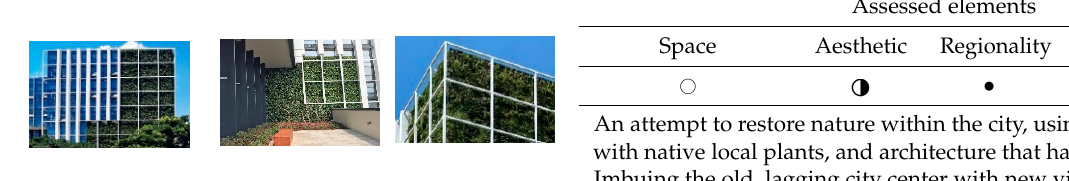
Table 3. Structural facades: Urban Hive (Archium 2008).